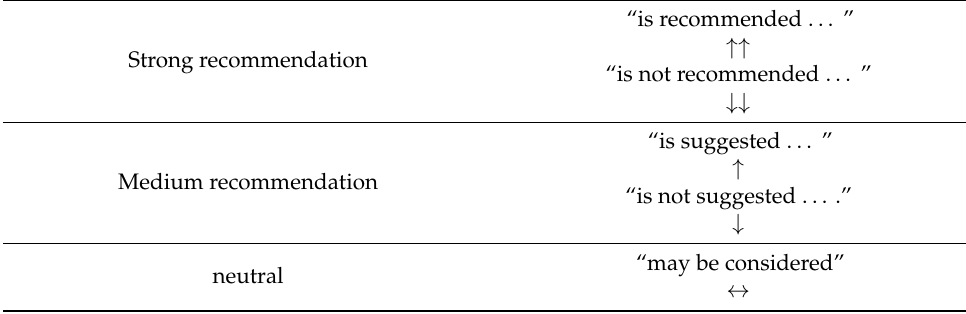
Table 1. Grades of recommendation (for details see Part 1;